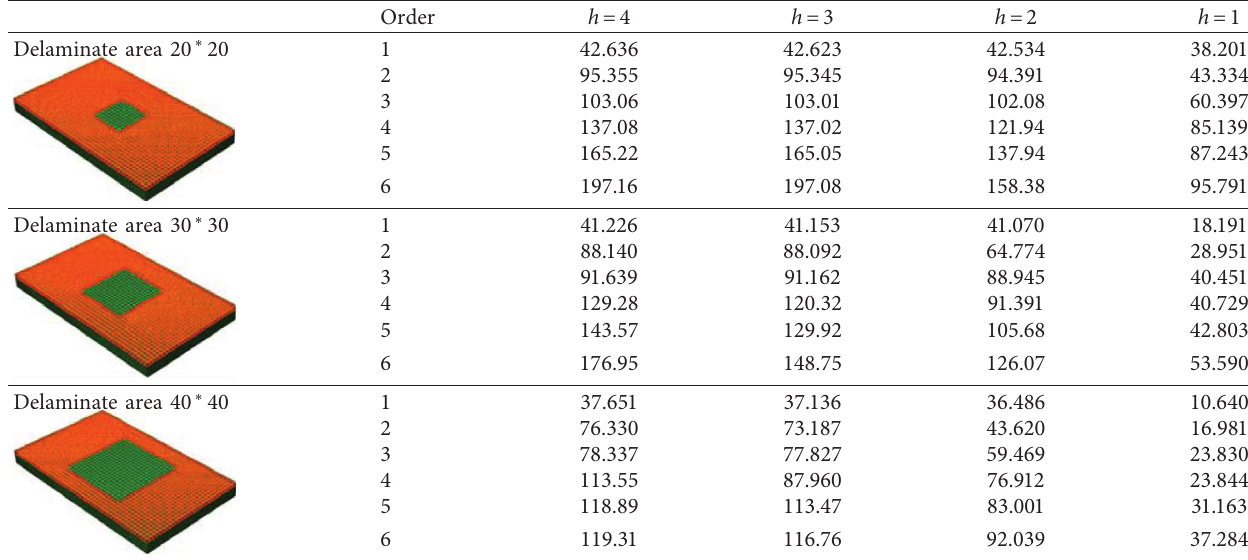
Figure 4: Setup of UDL: (a) the set direction in FE model; (b) layer Table 2: Buckling eigenvalues of FE analysis.